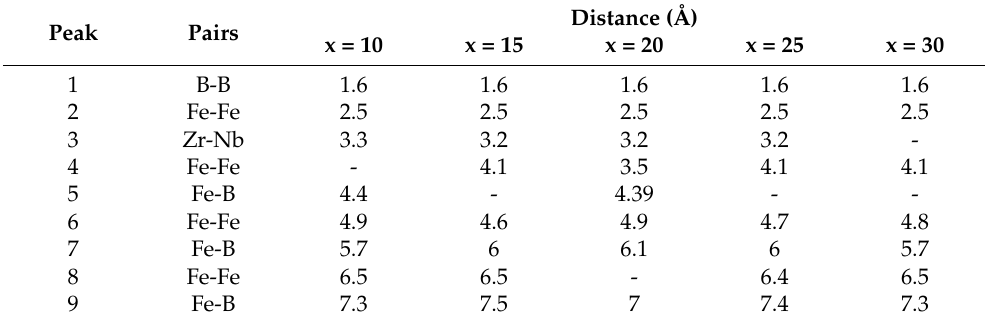
Figure 2. Radial distribution function (RDF) for Fe 91 − x Zr 5 Nb 4 B x (x = 10, 15, 20, 25, 30 at%) melt- spun ribbons. Table 1. Atom-pairs distance and peak positions for Fe 91 − x Zr 5 Nb 4 B x (x = 10, 15, 20, 25, 30 at%) alloys.